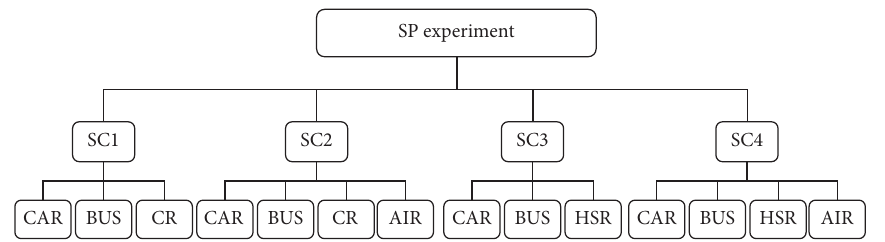
Figure 4: Combinations of mode choices in the SP